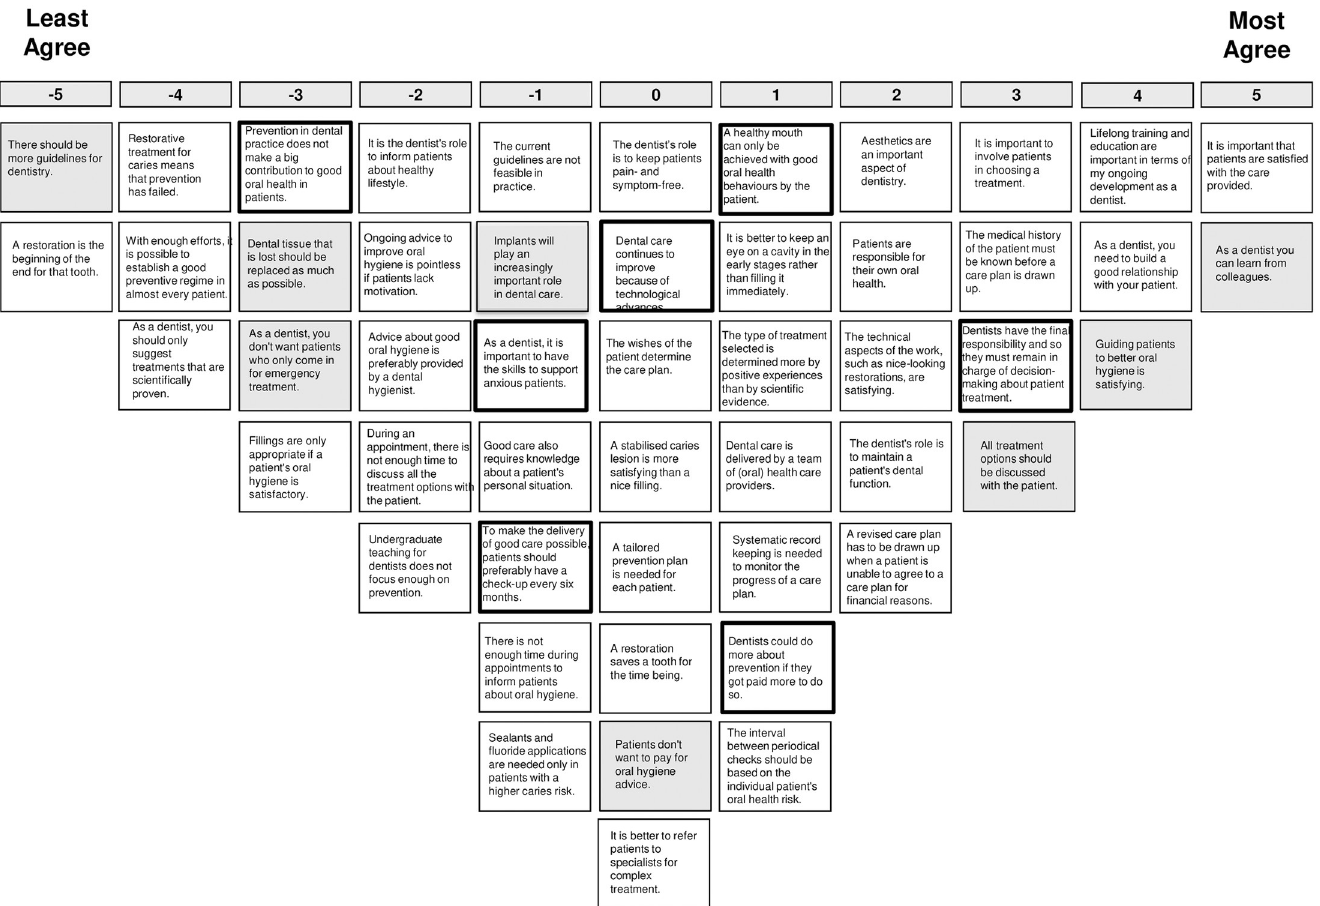
Fig 3. Score sheet for viewpoint 2. Note: Distinguishing statements p < 0.05 are shown in black outlined boxes, distinguishing statements p < 0.001 are shown in grey boxes.